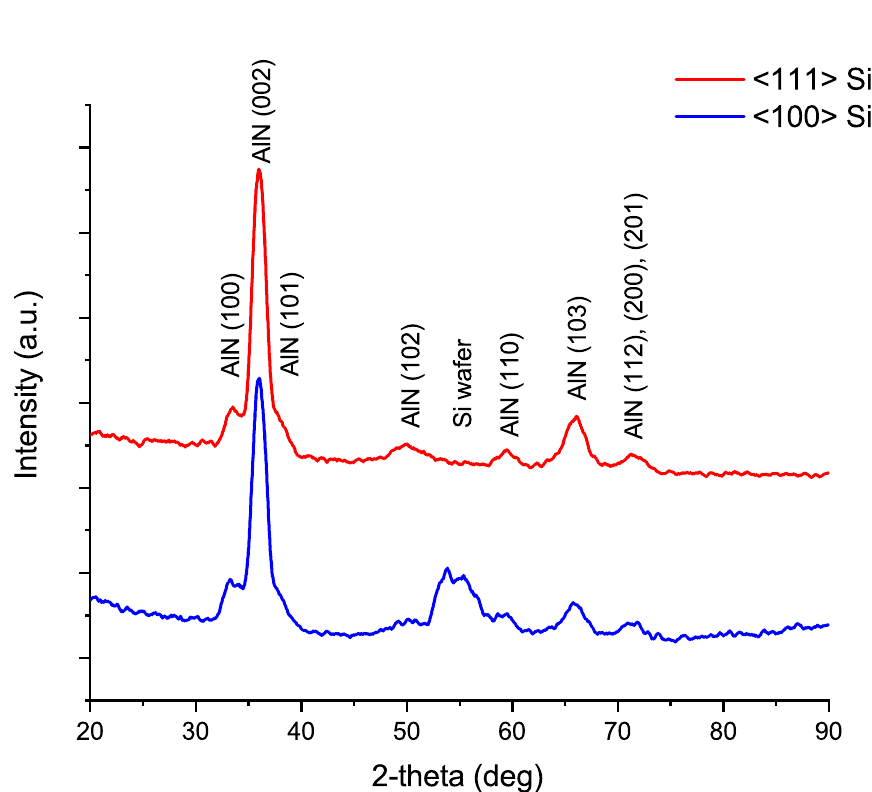
Figure 3. The 2-theta GIXRD patterns of 200W and 20s in situ ALA treated layers on Si<111> ( top ) and Si<100> ( bottom ).